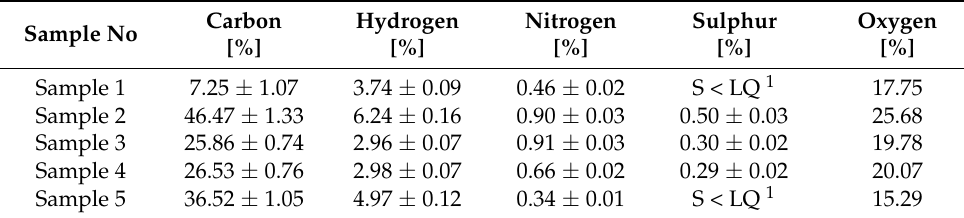
Table 4. Chemical composition of the MSW